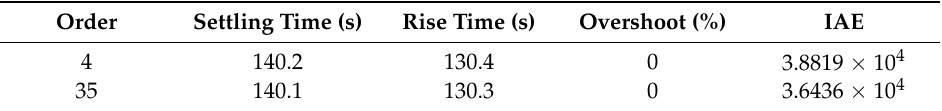
Table 2. (cid:1834) (cid:2998) full order and reduced order controller set-point performance indexes. Table 2. H ∞ full order and reduced order controller set-point performance